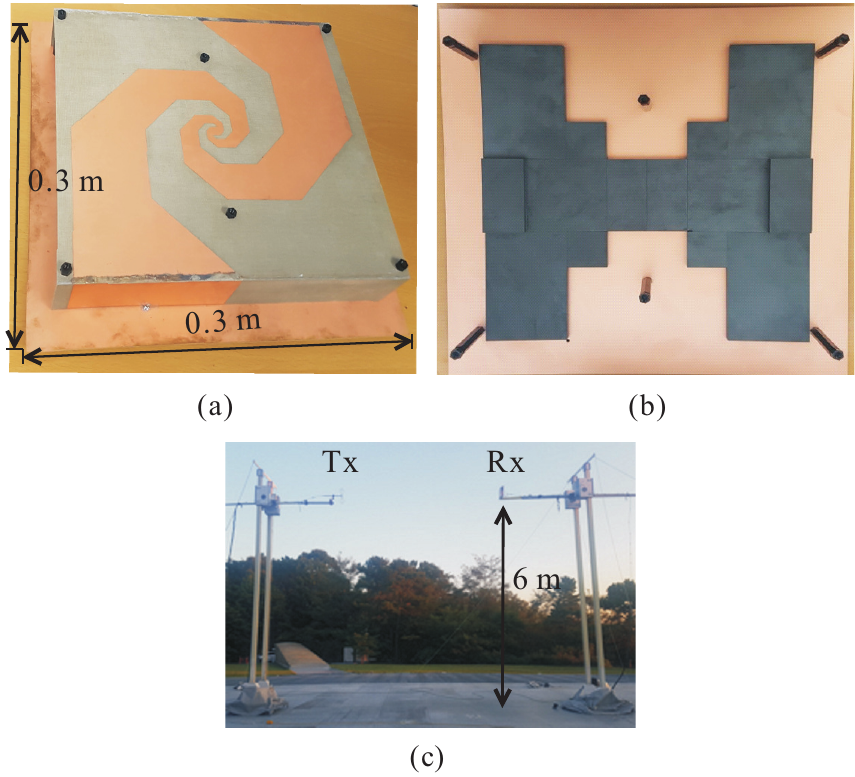
Figure 6. ( a ) 3-D view of the fabricated proposed antenna; ( b ) Top view of the optimized ferrite structure; ( c ) Antenna measurement circumstances.